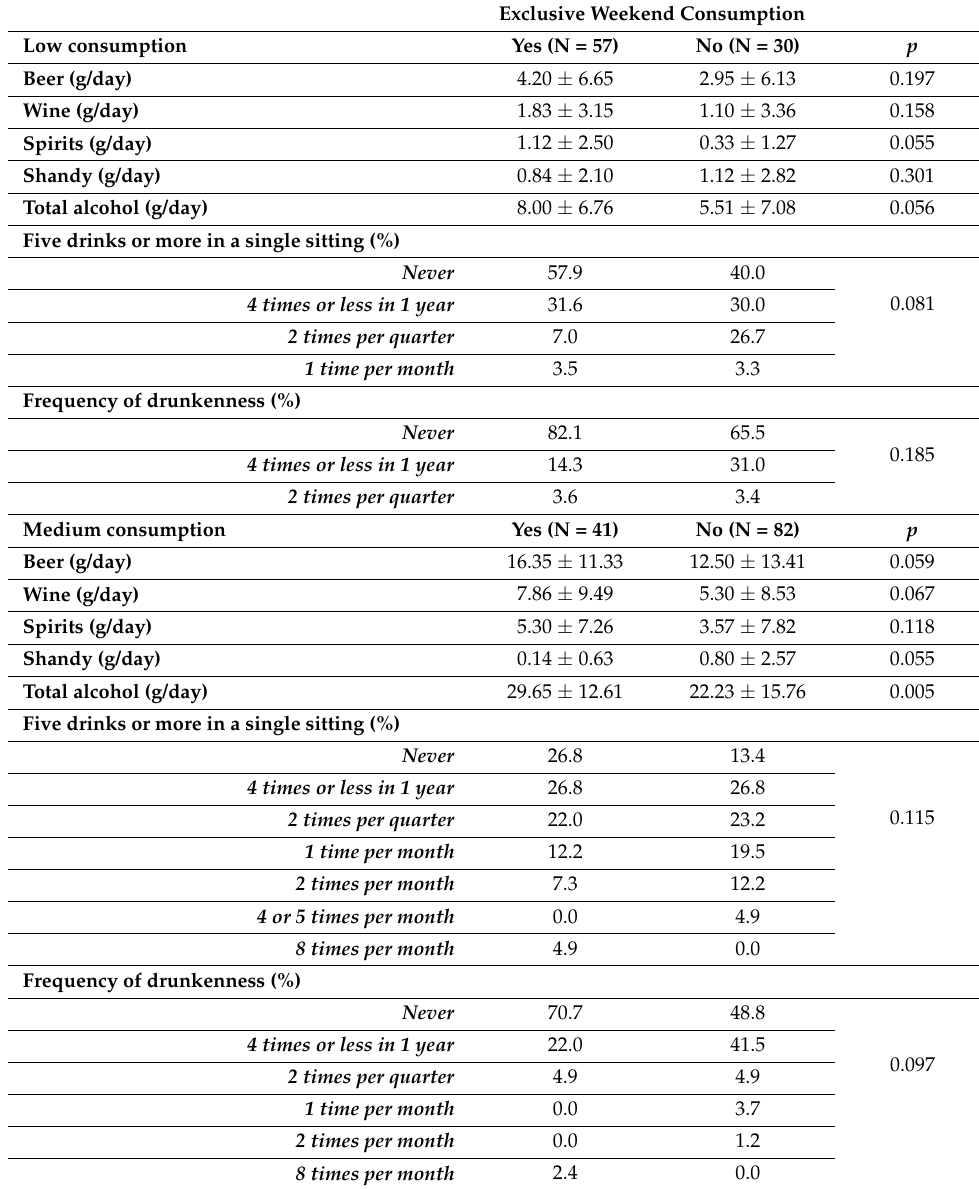
Table 4. Weekend consumption of each type of alcoholic beverage and alcohol consumption habits according to exclusive or non-exclusive weekend consumption for both alcohol consumption